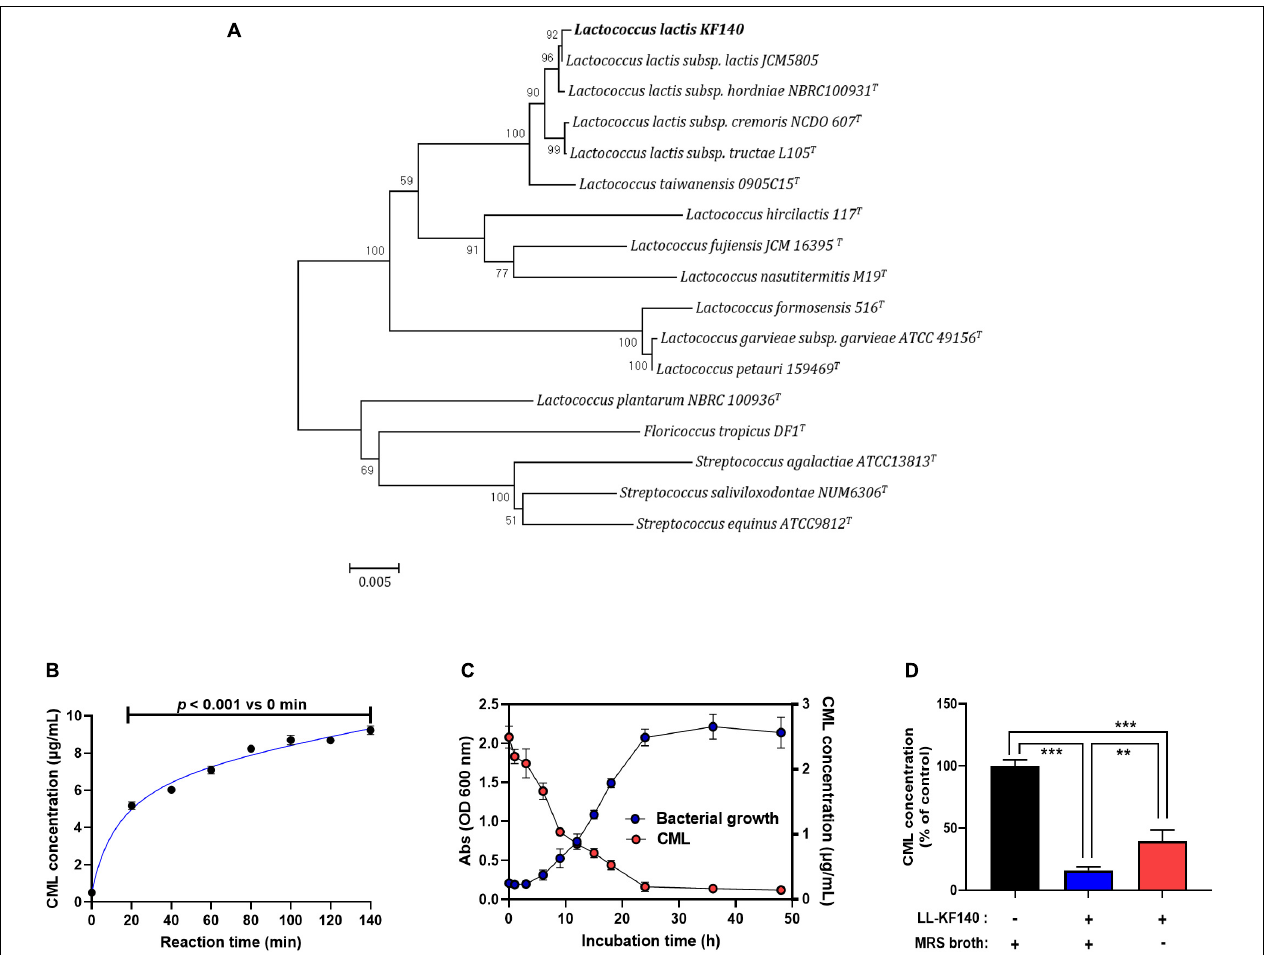
FIGURE 1 | Isolation of Lactococcus lactis KF140 (LL-KF140) and its reduction of N ε -(Carboxymethyl)lysine (CML) concentration in vitro test. (A) Neighbor-joining phylogenetic tree based on 16S rRNA gene sequences, showing the positions of L. lactis KF140 and other closely related lactic acid bacteria species. Bootstrap values (expressed as percentages of 1,000 replications) are shown at branching points. (B) Formation of CML following the reaction of casein and lactose at 140 ◦ C for different times. (C) Bacterial growth curve and the effect of LL-KF140 on the CML concentration in vitro . (D) Reduction of CML levels by LL-KF140 with or without MRS growth medium. Data are presented as the mean ± SD ( n = 3). ** p < 0.01, *** p < 0.001 (one-way ANOVA, followed by Tukey’s